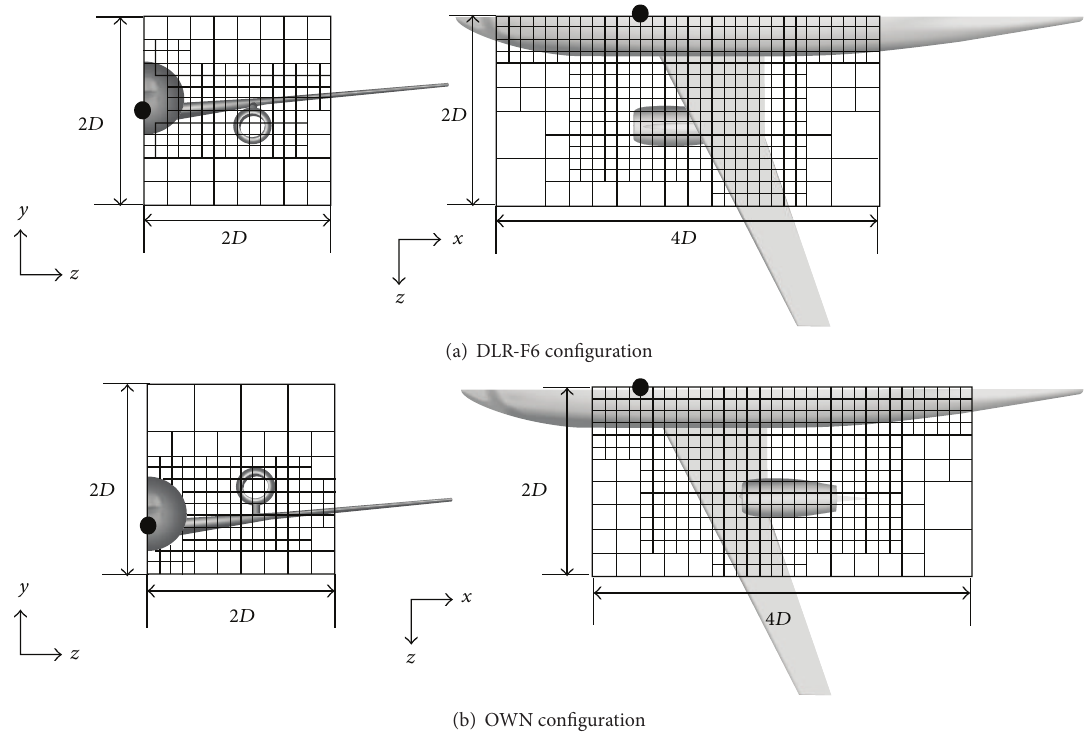
Figure 14: Computational domains for the fuselage-wing-nacelle configurations (black dot: origin of coordinate system).